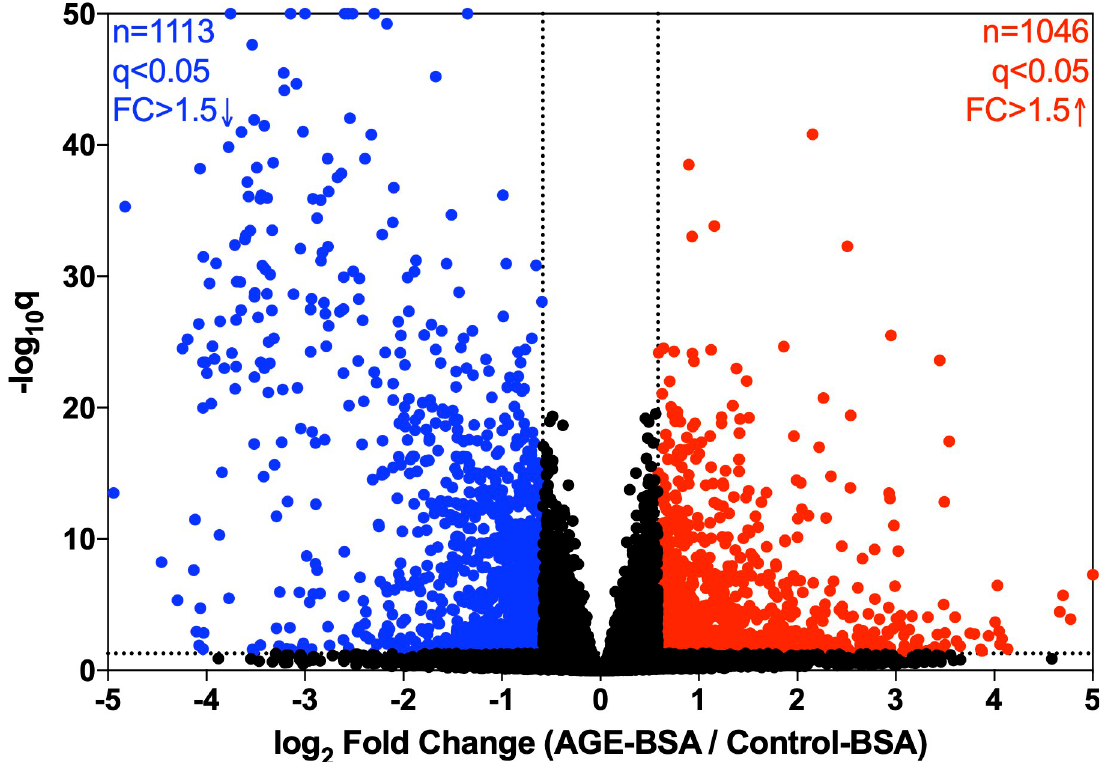
Fig 1. Volcano plot overview of RNA sequencing results. Each point represents a single gene target. Red (n = 1046) indicates significant increase in gene expression. Blue (n = 1113) indicates significant decrease in gene expression. Black (n = 10,648) indicates gene targets that were either unaltered or did not meet our thresholds of q < 0.05 and fold change of greater that 1.5 or less than